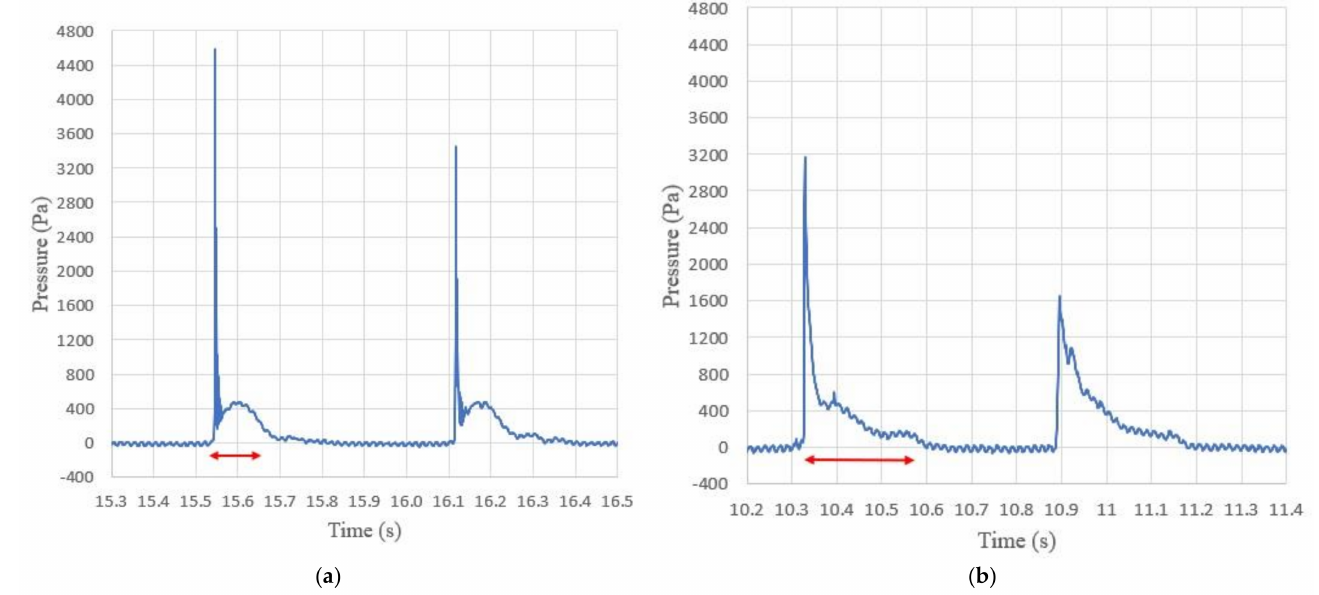
Figure 16. Measured pressure time series for the ( a ) no duct case at breaking wave position, and ( b ) the ducted case at breaking location and y / H br = 0 (swl). Red arrow indicates the duration of the pressure.